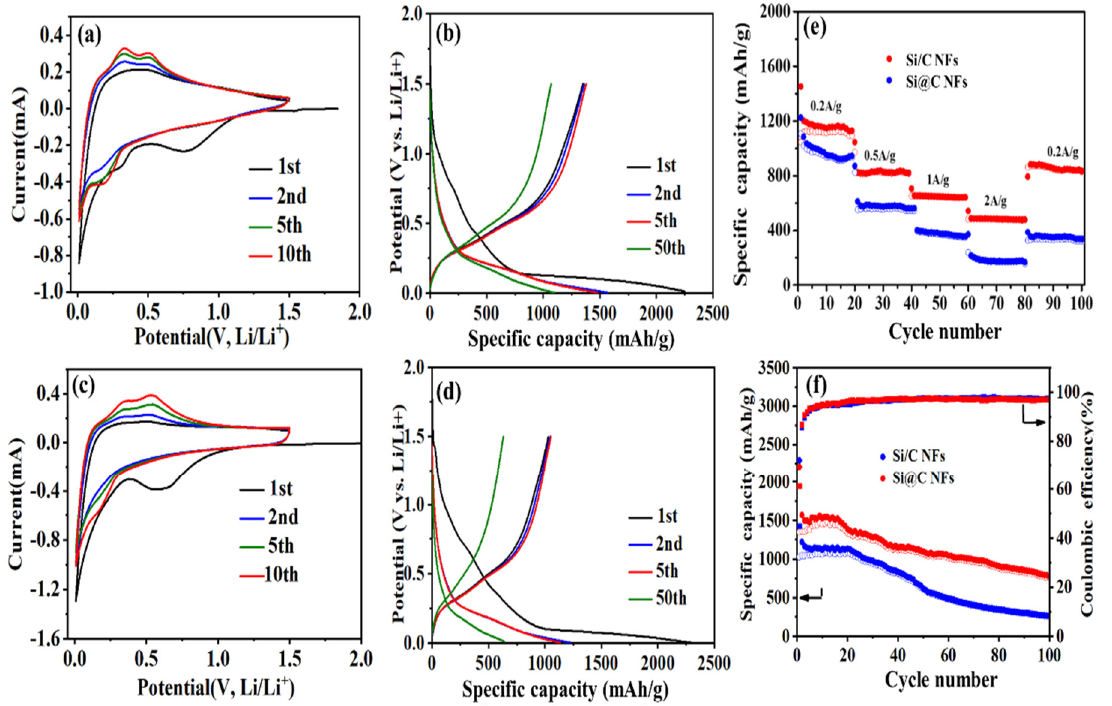
Figure 4. Cyclic voltammograms curves of ( a ) Si@C NF and ( c ) Si/C NF electrodes; galvanostatic charge/discharge profiles of ( b ) Si@C NF and ( d ) Si/C NF electrodes; ( e ) rate capabilities of Si@C NFs and Si/C NFs electrodes at a current density of 0.2–2A g − 1 ; ( f ) cycling performances of Si@C NFs and Si/C NFs electrodes at a current density of 0.1 Ag − 1 .